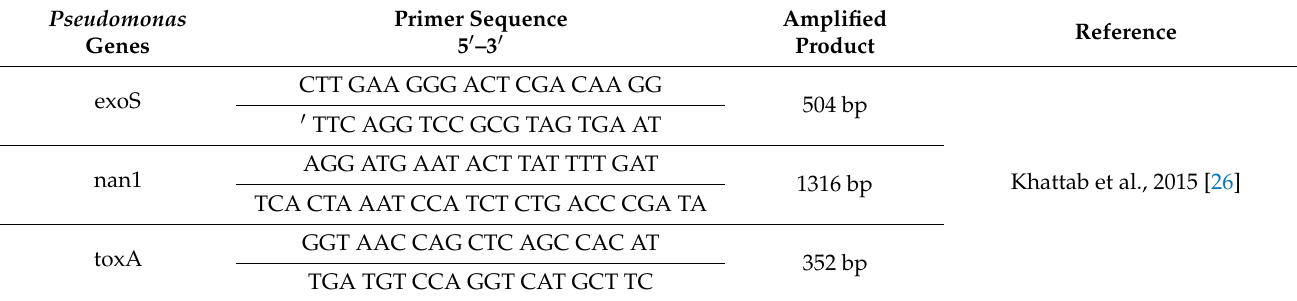
Table 2. Oligonucleotide primers